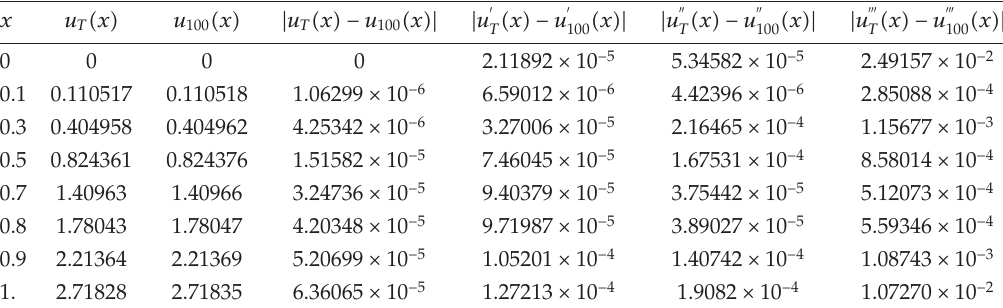
Table 5: The numerical results of Example